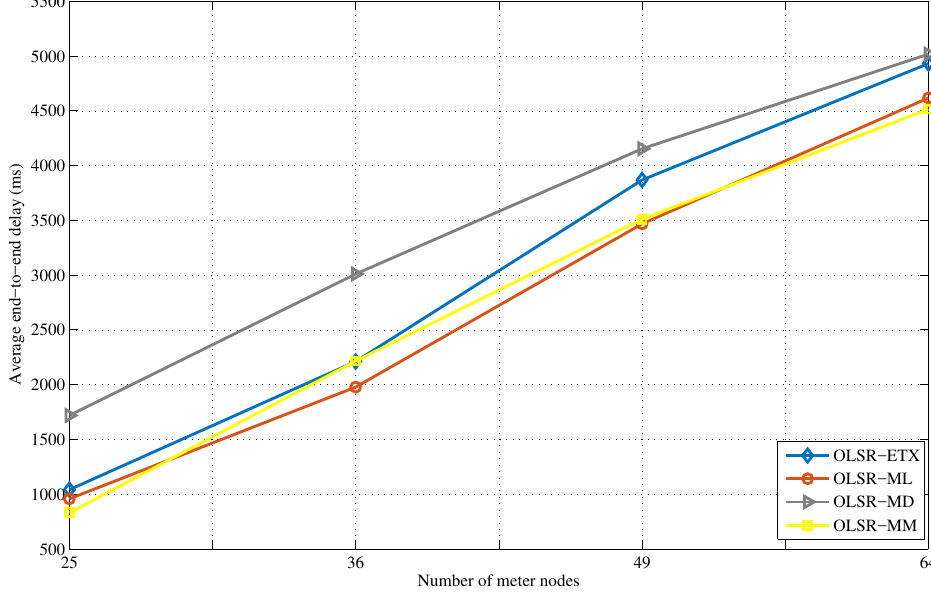
Figure 15. Average end-to-end delay for SG application on grid clusters with the data concentrator placed at the top